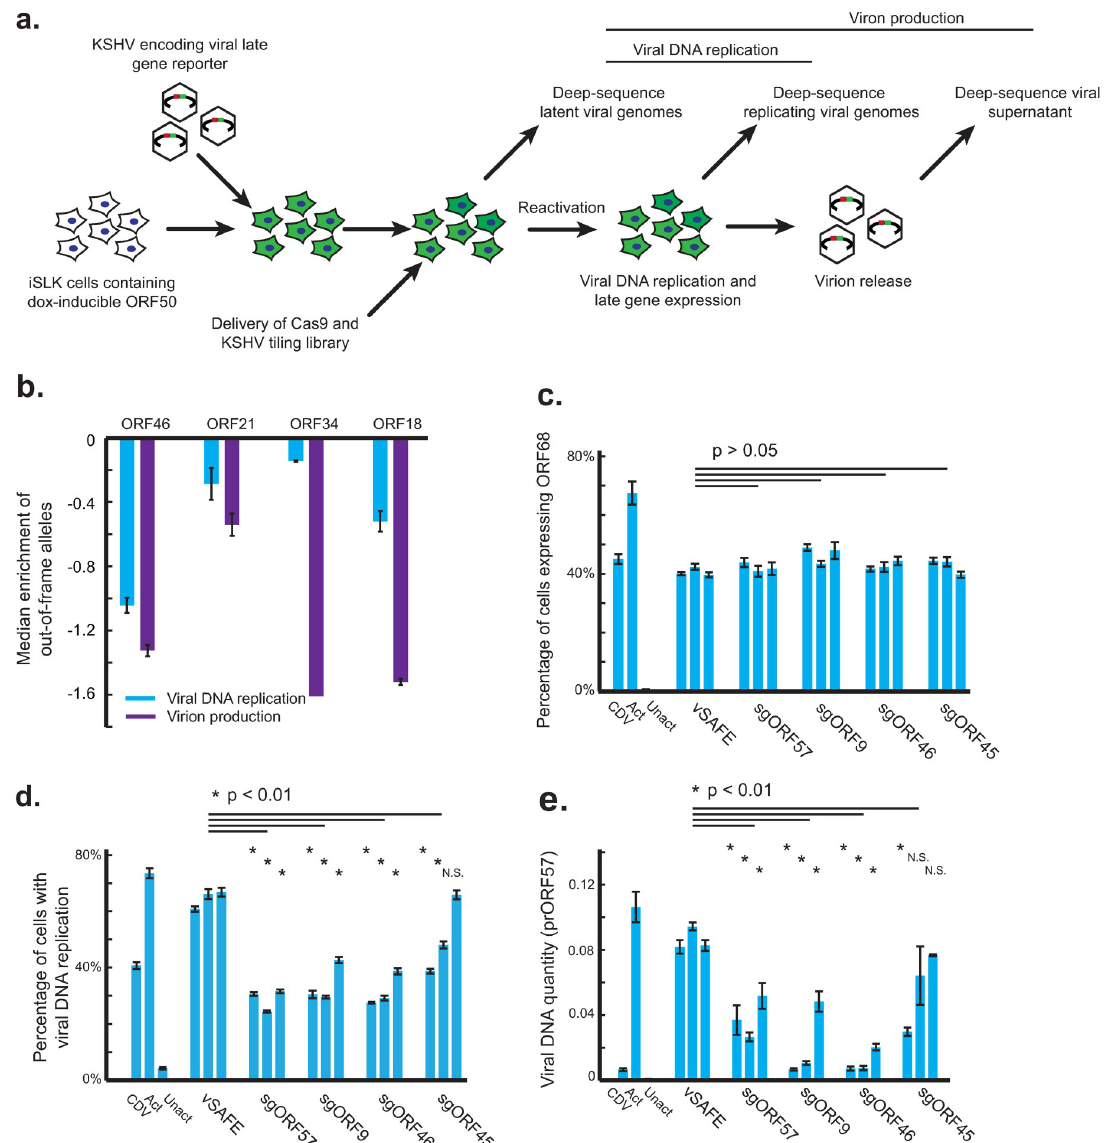
Fig 3. Deep viral sequencing identifies ORF46 requirement for viral DNA replication. a) Design of targeted deep-sequencing experiment. Four viral loci were amplified and deep-sequenced: ORF21, ORF18, ORF34, and ORF46. b) Median enrichment across the coding region of the gene of out-of-frame indels in replicating cells relative to latent cells (Viral DNA replication) or the supernatant relative to latent cells (Virion production). Error bars are standard error from two replicates. One replicate of ORF34 supernatant sample was excluded due to uneven coverage. c,d,e) Three individual sgRNAs were lentivirally delivered to KSHV-infected iSLK cells targeting the indicated viral ORF. Error bars are standard error from four independent reactivations. CDV-treated, reactivated, and unactivated parental cells are included as controls, along with three vSAFE sgRNAs targeting an ORF-free region of the BAC. P values were calculated using a single-tailed, equal variance Student’s t-test, with the least significant value used when compared to each individual vSAFE sgRNA. NS indicates non-significance (P > 0.01). c) Reactivation and early gene expression was measured using a KSHV virus containing a HaloTag fusion to a viral early gene, ORF68. d) Measuring viral DNA replication by percentage positive EdU staining. A 2-hour pulse of EdU was delivered 48 hours post reactivation. Cells were then fixed, and click chemistry was used to measure EdU incorporation by flow cytometry. Unreactivated cells were used to establish gates for flow cytometry, where subgenomic EdU incorporation was measured as viral DNA replication. e) DNA was extracted 48 hours post reactivation, and qPCR of the viral promoter of ORF57 was used to measure the amount of viral DNA.